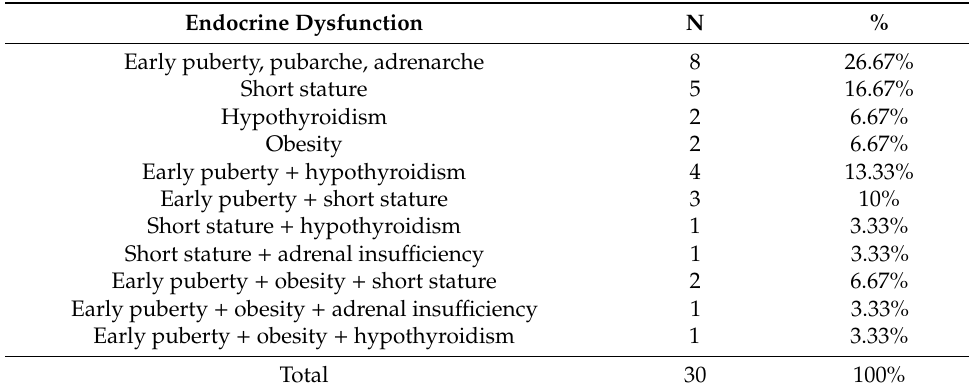
Table 2. Endocrine dysfunctions seen alone and in combination among children with ZikV-associated microcephaly in in the Microcephaly Epidemic Research Group (MERG) Cohort evaluated between February and June 2019 in Recife, Pernambuco, Brazil (N =